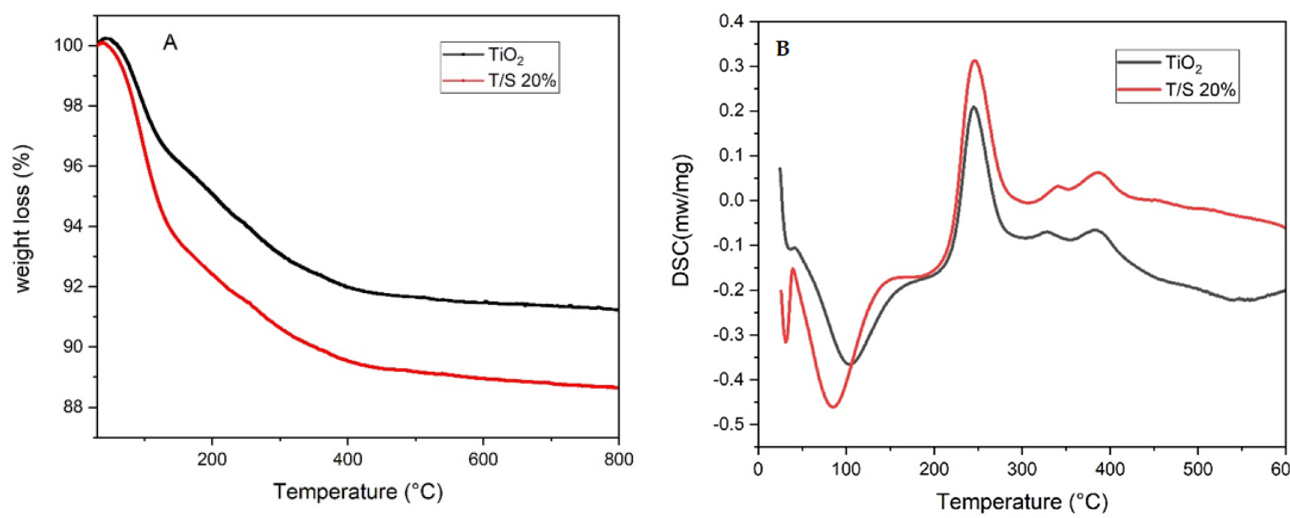
Figure 1. ATG ( A ) and DSC ( B ) curves of pure TiO 2 and 20% T/S composite.